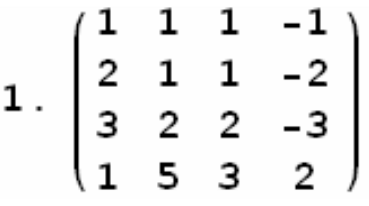
Figure 4. Matrix to reduce to the echelon forms